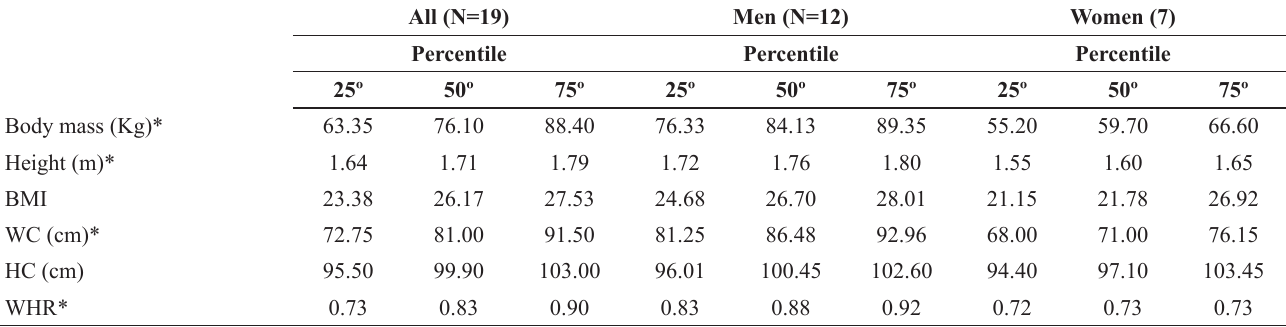
Table 1 - Anthropometric measures of volunteers (12 males and 7 females), Vila Real, Portugal, 2019.